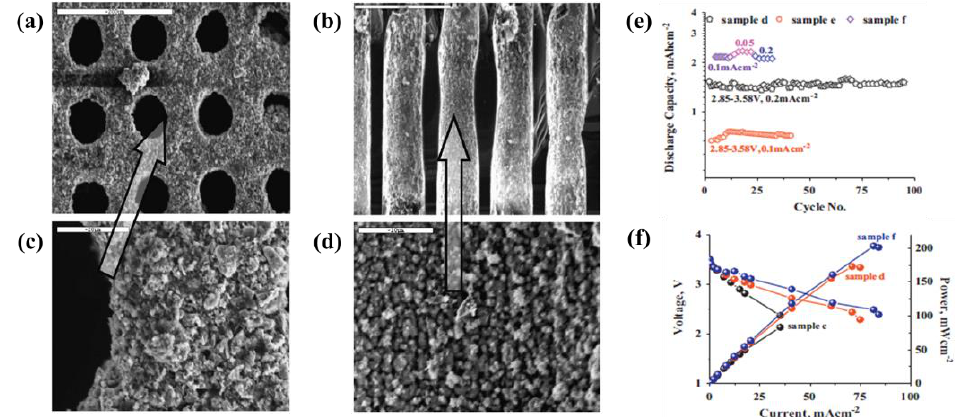
Figure 7. 3D-LiFePO 4 thin film prepared by EPD as the cathode for Li ion batteries: ( a ) Planar image of LiFePO 4 -coated 3D sample; ( b ) cross-section of the channels; ( c ) enlarged image of ( a ); ( d ) enlarged image of ( b ); ( e ) The electrochemical cycling performance of sample c (2D-LiFePO 4 thin film), sample d (3D-LiFePO 4 thin film), and sample f (CuS coated 3D-LiFePO 4 thin film) at various C-rates and voltage cutoffs; ( f ) Polarization curves of samples ( c , d , f ).